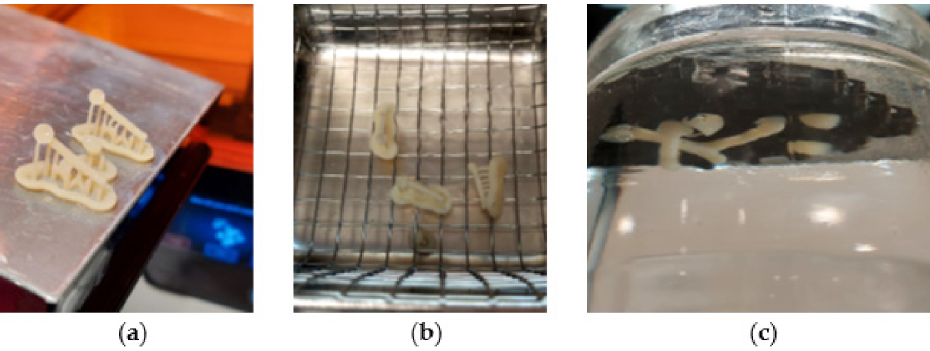
Figure 13. ( a ) Fresh 3D printed three clones of a distalizer from Denture teeth resin material; ( b ) sonic IPA bath for 10 min; ( c ) post-curing submerged in glycerine in 80 ◦